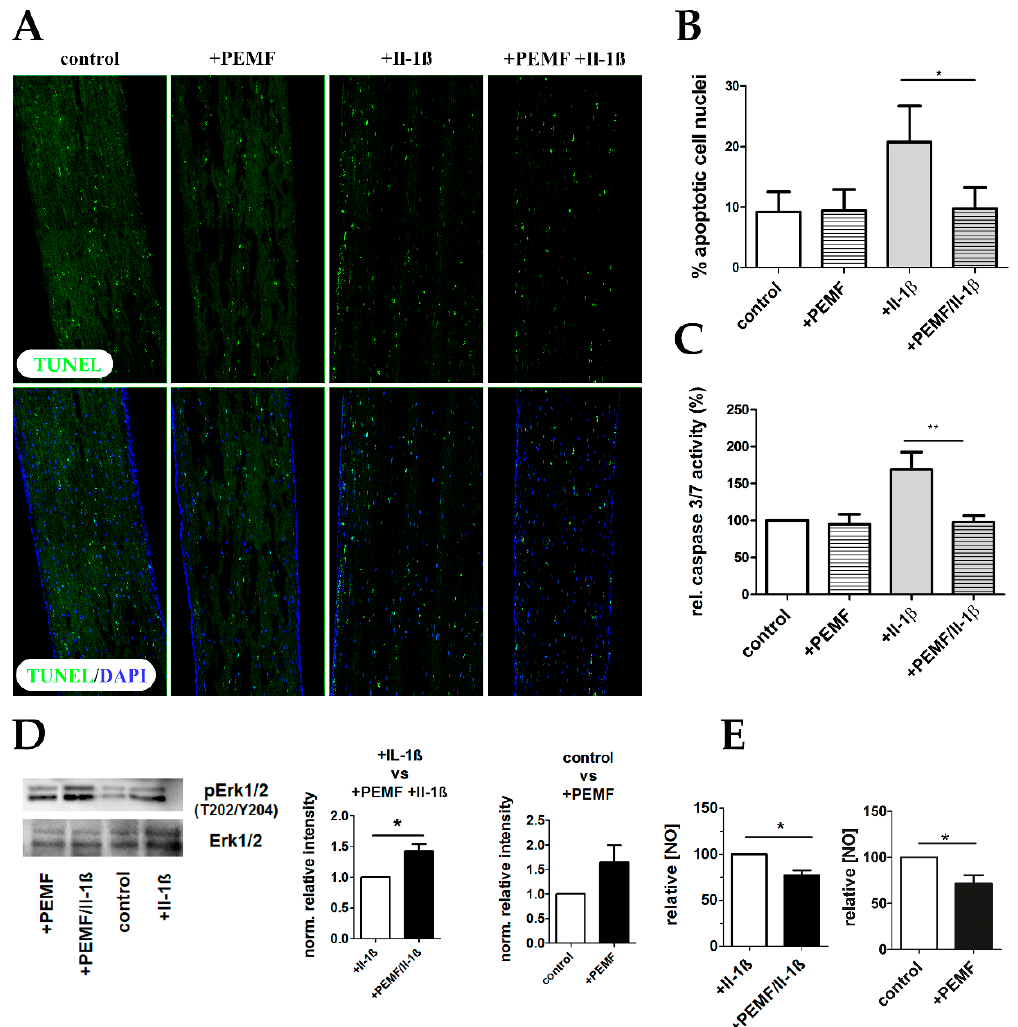
Figure 9. PEMF treatment attenuates apoptosis in pro-inflammatory stimulated tendon-like constructs. ( A ) TUNEL Assay was performed to visualize apoptotic cell nuclei (green) showing the characteristic fragmented phenotype. ( B ) Percent apoptotic cell nuclei was determined, demonstrating an anti-apoptotic e ff ect of PEMF exposure of Il-1 β -primed 3D constructs. ( C ) Caspase3 / 7 enzyme activity was determined in protein lysates of tendon-like constructs of all for treatment groups, confirming that PEMF treatment significantly decreases apoptosis in pro-inflammatory stimulated samples. ( D ) Representative Western blot and densitometric analysis ( n = 4) for phosphoERK1 / 2 and totalERK1 / 2 demonstrate activation of ERK1 / 2 after PEMF exposure. ( E ) Total NO concentration is significantly reduced in cell culture supernatants of + PEMF + Il-1 β and + PEMF treated tendon like constructs ( n = 5). * p < 0.05, ** p < 0.01.